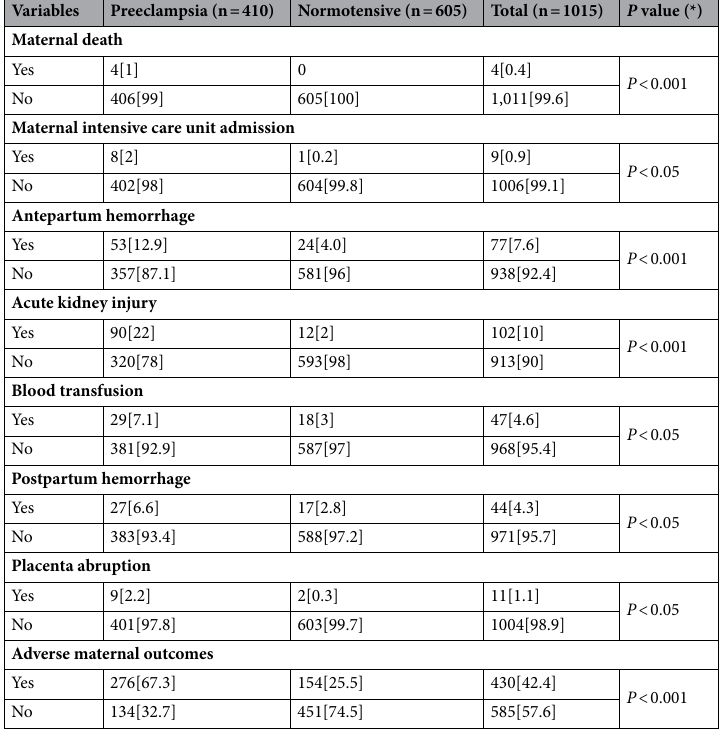
Table 3. Maternal outcomes among women with preeclampsia and normotensive women in Sidama region, southern Ethiopia from August 8, 2019, to October 1, 2020. * P value < 0.05 was considered statistically